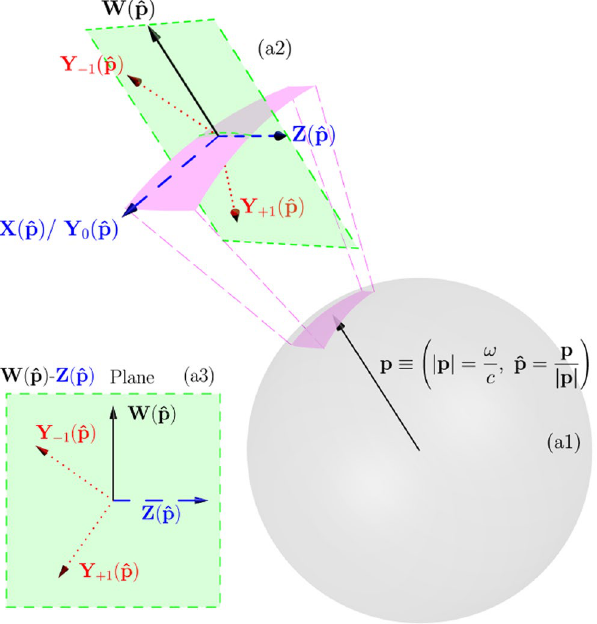
Figure 2. Only the transverse components of the current density J ω ( p ) with = ω ˆ p p produce electromagnetic c fields outside the source region (see Fig. 1). ( a1 ) Spherical shell of radius = ω p in momentum space. The ( a2 ) c region depicts two different orthonormal bases for vector functions defined on the shell. The ˆ ˆ X and the . The ( j , m ) indexes are omitted in the figure, and the subscript in the Y ’s is the difference between their second and first indexes. The two bases are related to each other as written in Eq. (7). With respect to their polarization vectors: ˆ X are orthogonal (transverse) to the momentum vector p , ˆ W p ( ) is parallel (longitudinal) to p , and and jm m , 1, lay in the plane and are neither transverse nor longitudinal, as seen in ( a3 ). The transverse vectors are represented by dashed blue arrows, the longitudinal ones by solid black arrows and the ones of mixed character by dotted red arrows. For the figure, we took j = 1 in Eq. (7) for the relationships